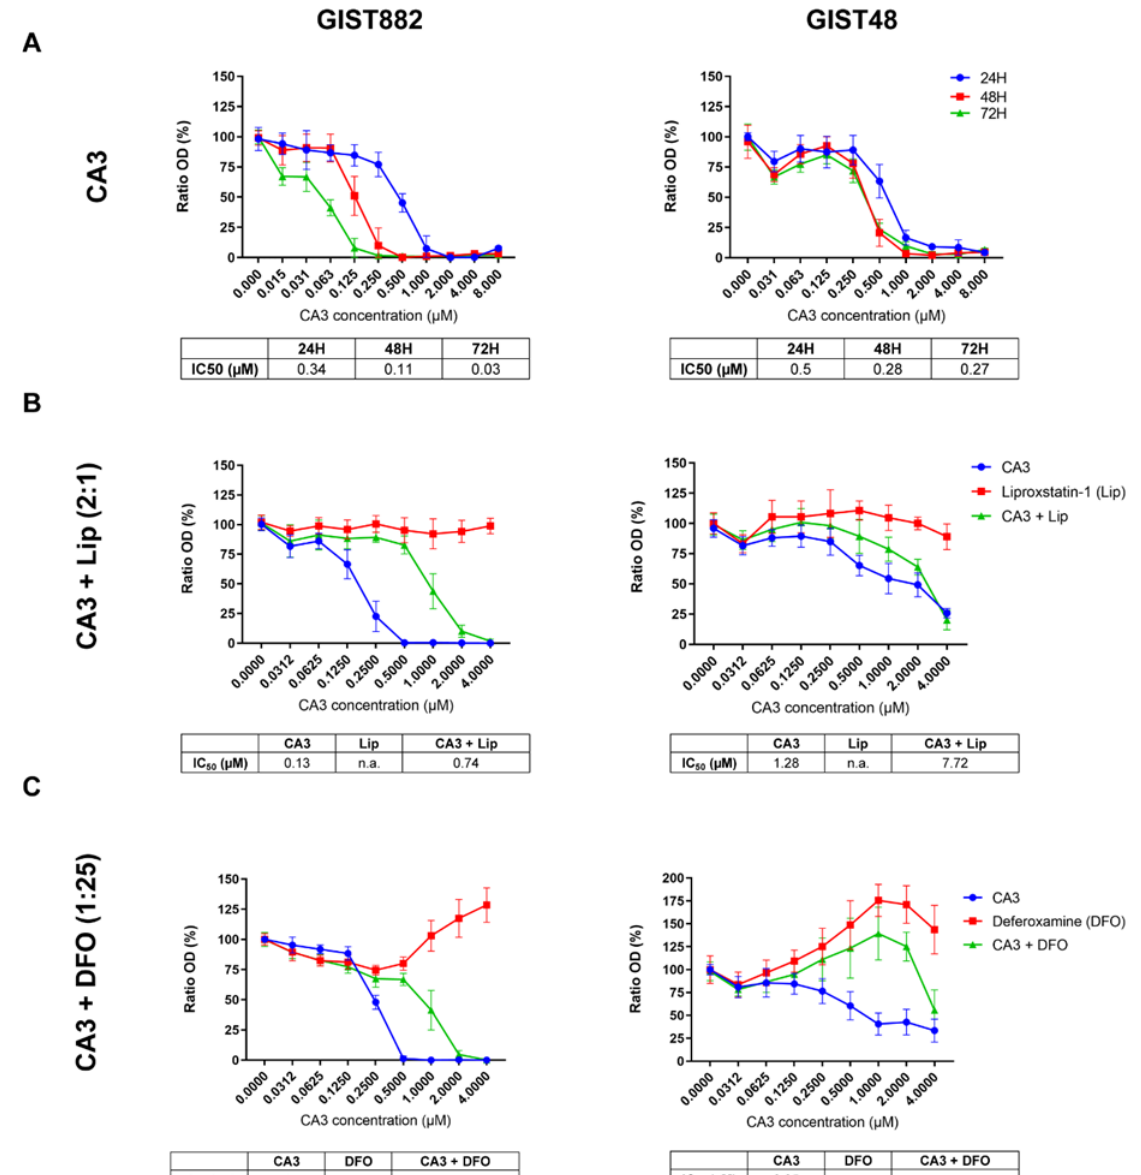
Figure 4. CA3 induces massive loss of cell viability, which is reduced by the iron chelator DFO and, to a lesser extent, by the antioxidant Lip in GIST882 and GIST48 cell lines. WST-1 viability assays in GIST882 and GIST48 cells are shown in the left and right panels, respectively. ( A ) Cells were treated with different concentrations of CA3 for 24, 48, and 72 h. ( B ) Cells were treated for 24 h with a combination of different concentrations of CA3 and Lip, with a 2:1 ratio, or ( C ) with a combination of different concentrations of CA3 and DFO, with a 1:25 ratio. IC50 values are shown under the viability graphs. Mean values ±SD are shown for three or four independent experiments with three technical replicates for each experiment.